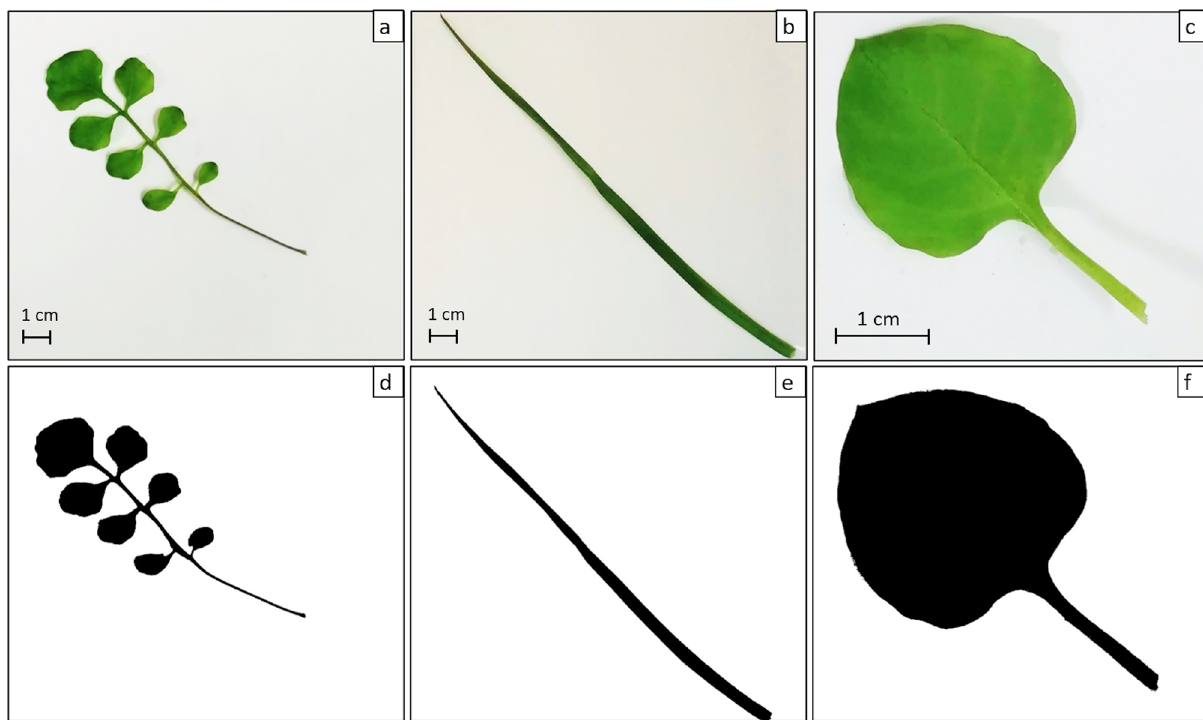
Figure 2. Binary transformation of leaves used to calculate leaf area, in the three tested species: ( a – d ) Cardamine hirsuta ; ( b , e ) Poa annua ; ( c – f ) Stellaria media . Photographs by M.